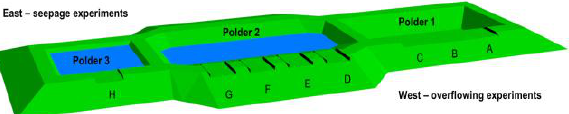
Figure 1. Test dike in Rostock-Markgrafenheide (project DredgDikes,